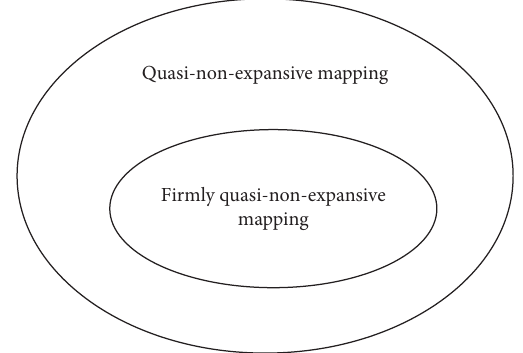
Figure 4: The relations of some nonlinear